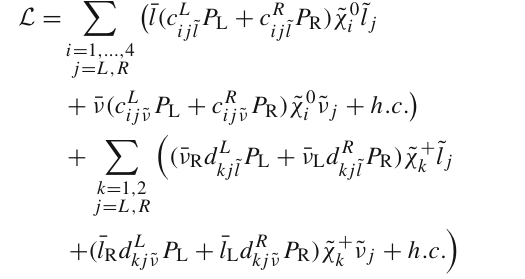
R-sneutrinos are denoted as ˜ ν 1 , 2 , 3 . Notice that in our results we use the full formulas shown in Appendices A and